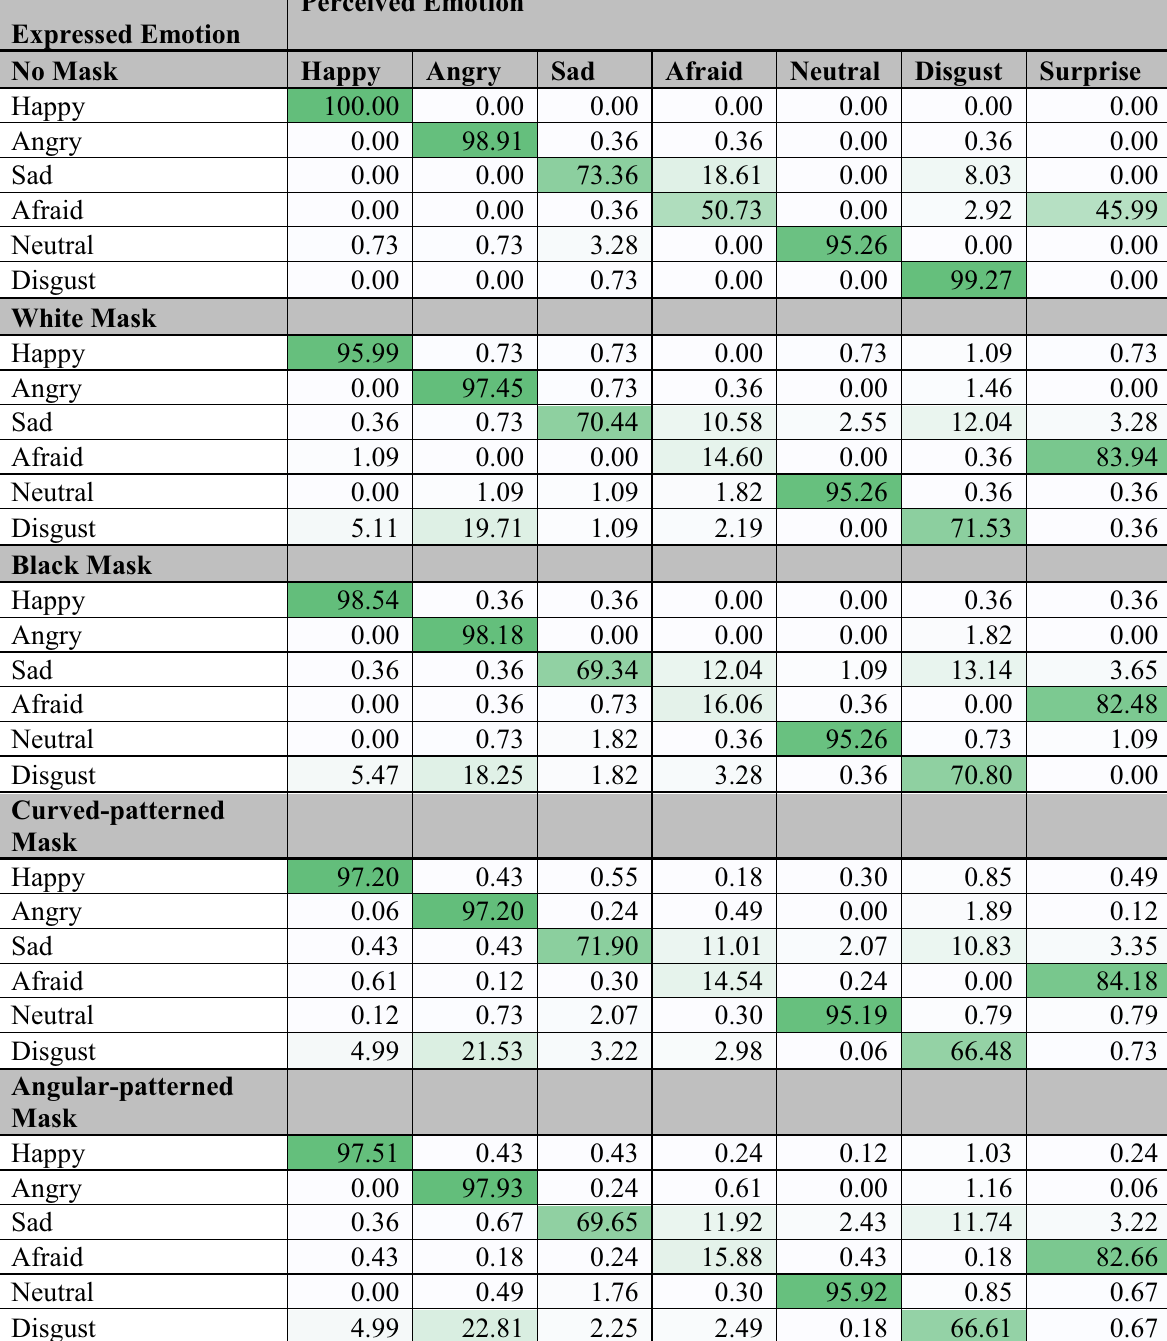
Table 1 Confusion matrix of emotions Expressed